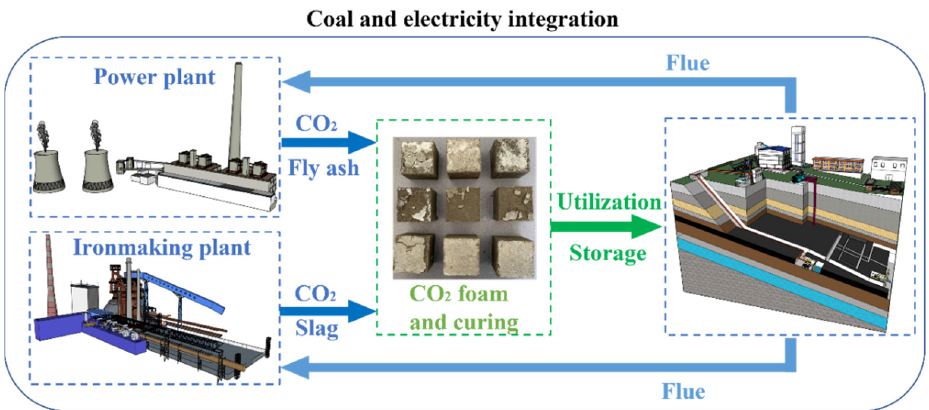
Figure 11. Scheme of eco-friendly production of PC-CFC from solid waste and CO 2 to coal mines. Ironmaking plants and coal-fired power plants supply solid wastes (fly ash and slag) and CO 2 , and coal mines supply flue. Power plants and ironmaking plants source materials from the